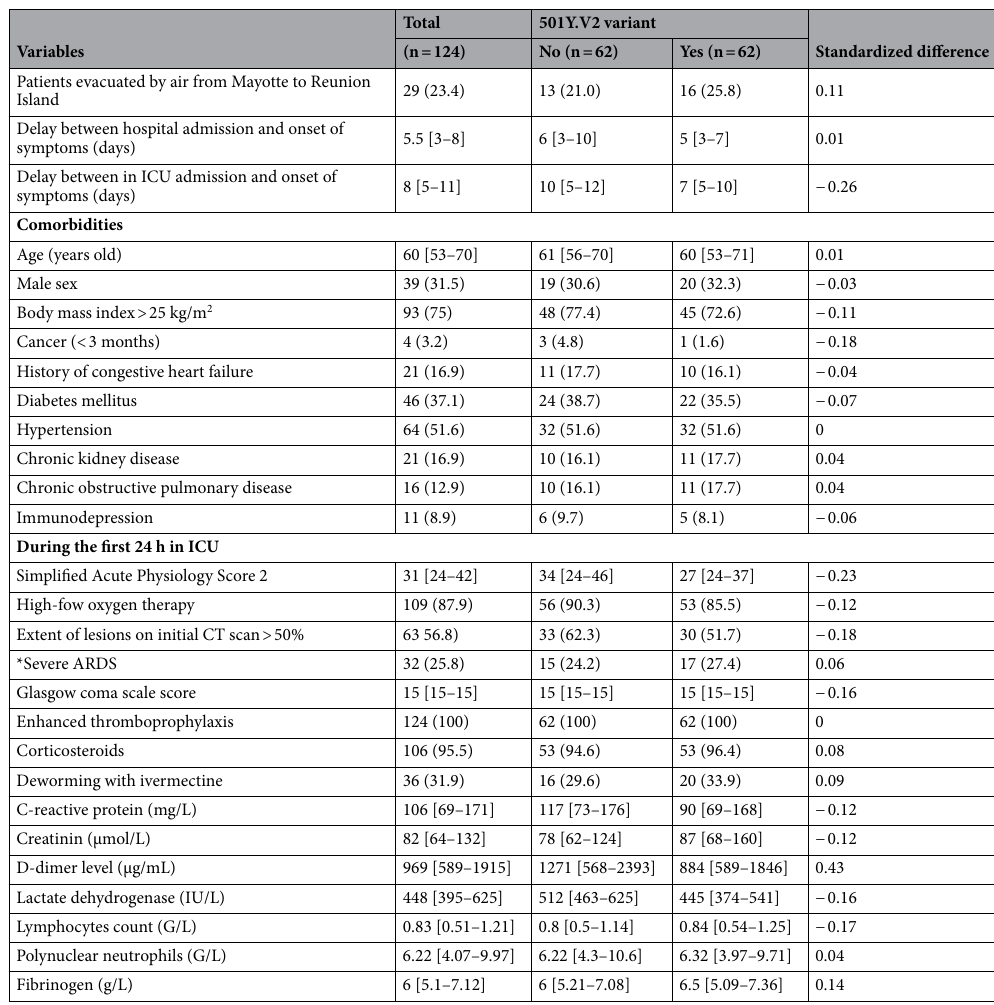
Table 2. Baseline patient characteristics in propensity-matched groups. ARDS acute respiratory distress syndrome, CT computed tomography, ICU intensive care unit. Results are expressed as total numbers (percentages) for categorical variables and as medians [25th–75th percentiles] for continuous variables as appropriate. *Defned as PaO2/FIO2 ratio ≤ 100 mmHg with PEEP ≥ 5 cm